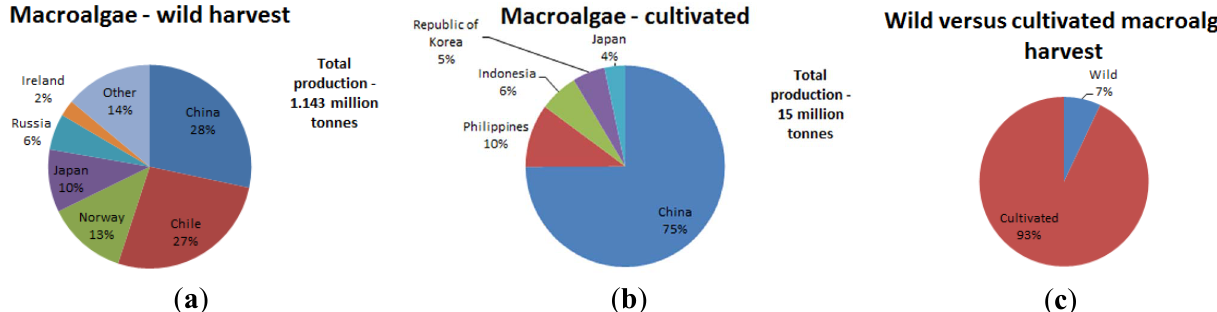
Figure 3. Breakdown of macroalgae ( a ) wild harvest by region; ( b ) cultivated harvest by region; and ( c ) wild versus cultivated in 2011